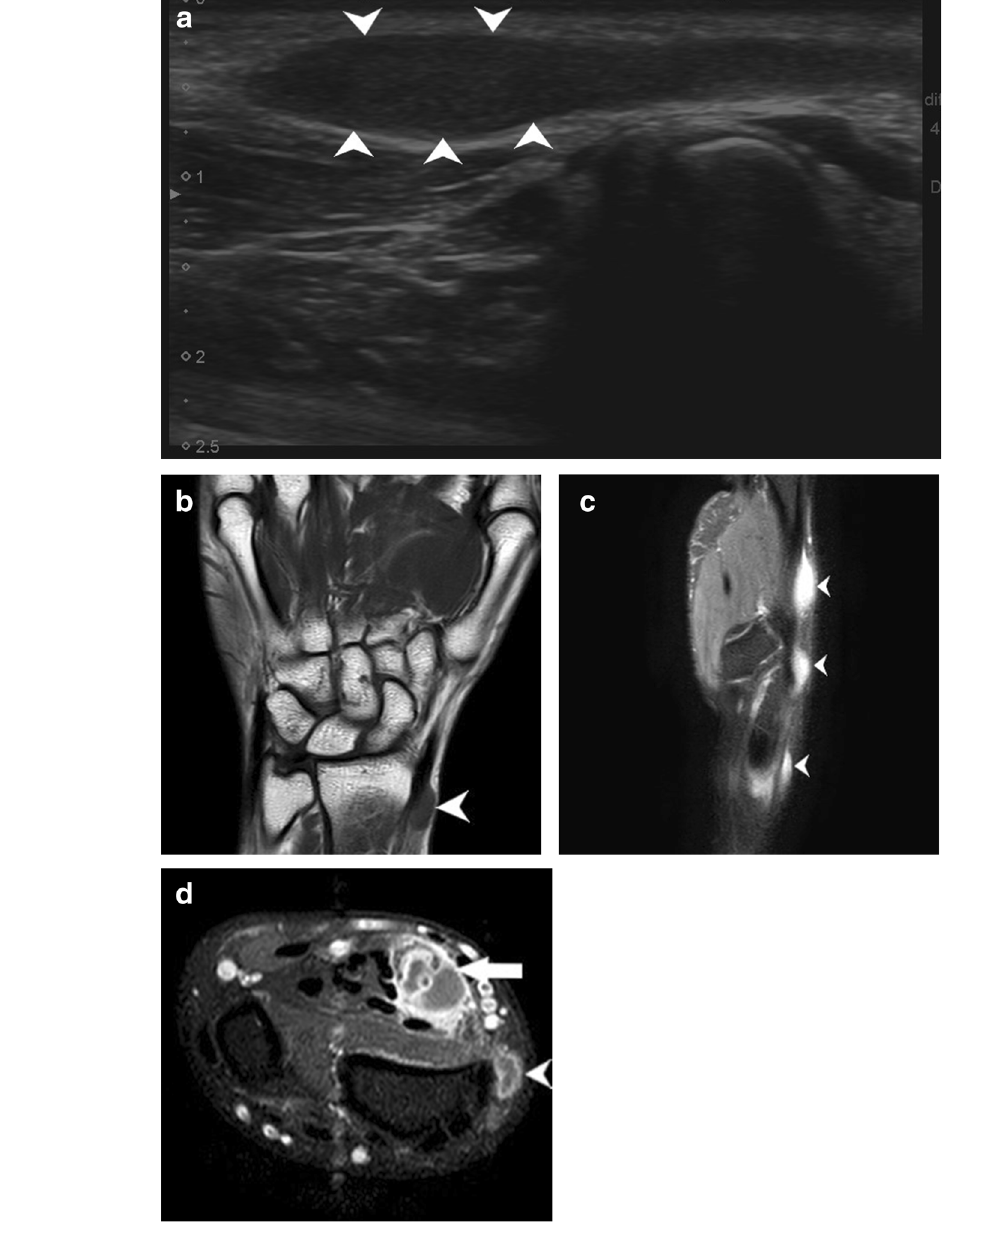
Fig. 11 a Well-defined fusiform hypoechoic lesion (white arrowheads) is noted in continuity of the superficial branch of the radial nerve in the region of the anatomical snuffbox, just distal to the radial styloid. b T1-weighted coronal image shows another well-defined, T1 hypointense, fusiform lesion (white arrowhead) in continuity with the superficial branch of the radial nerve at the distal end of the radius. c PD fat- saturated sequence in the sagittal plane showing multiple PD hyperintense lesions (white arrowheads) along the superficial branch of the radial nerve. The lesions were hyperintense on T2 sequence also, showing internal fascicular areas suggestive of neural origin. d Axial post- contrast fat-saturated T1 image showing well-defined hypointense lesion surrounded by an enhancing capsule (arrowhead) in continuity with the superficial branch of the radial nerve. Another similar lesion (arrow) showing